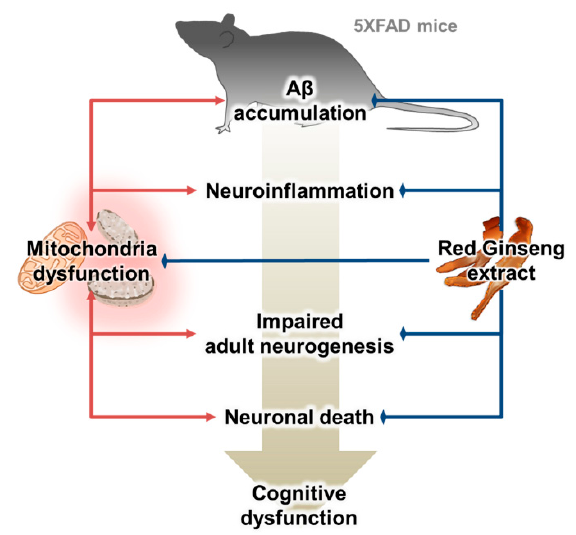
Figure 6. Schematic diagram of the effect of RGE on Alzheimer’s disease (AD) pathology modulated by A β -induced mitochondrial dysfunction.